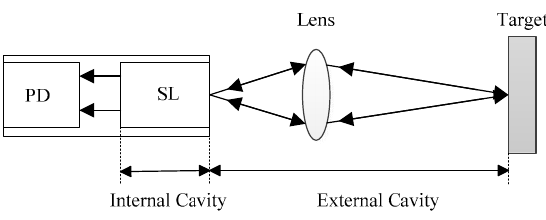
Figure 1. Schematic configuration of an SMI.